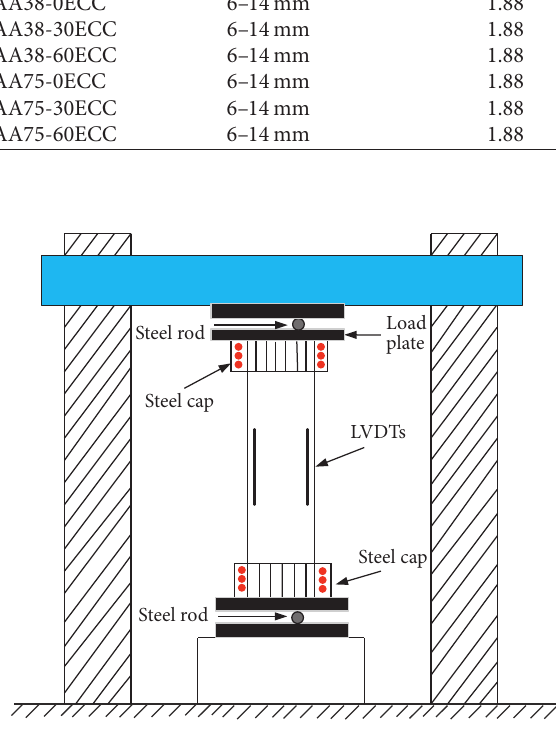
Figure 2: Basic testing arrangement for eccentric